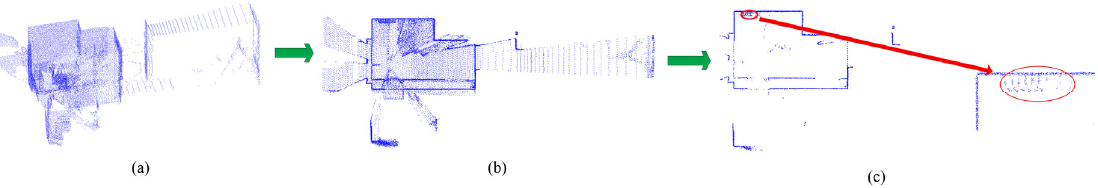
Figure 1. The process of extracting the points on 2D lines. ( a ) The original point cloud, ( b ) 2D point cloud obtained by projecting the original point cloud on the horizontal plane, ( c ) the points with high point density are extracted.